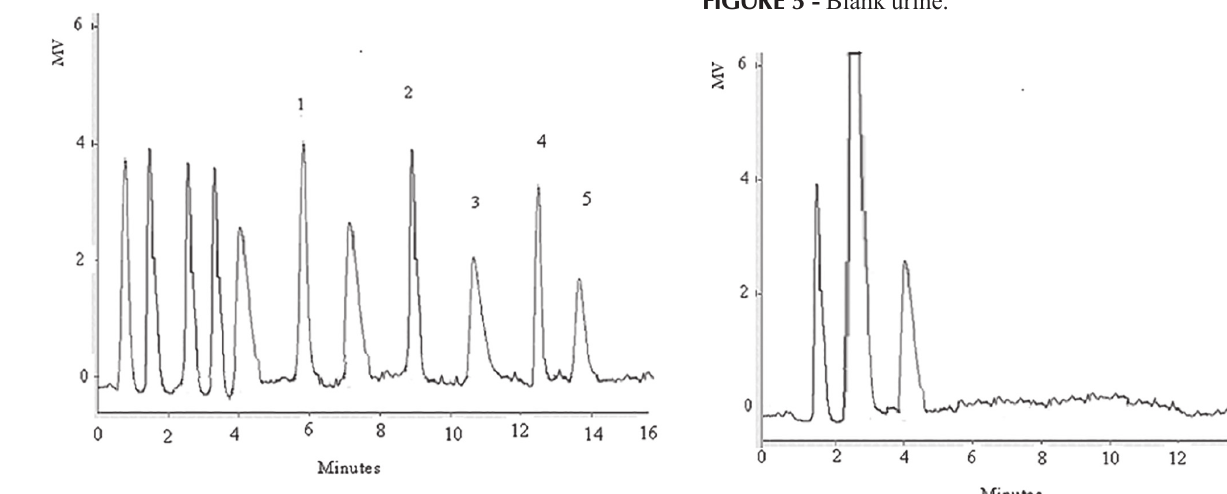
FIGURE 2 - Chromatogram in API .1=Metformin, 2=Sitagliptin, 3= Rosiglitazone, 4=Pioglitazone, 5=Glimepiride.